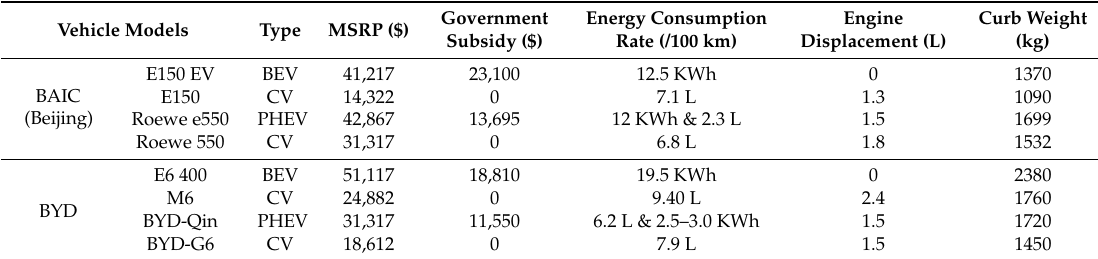
Table 11. Vehicle models and